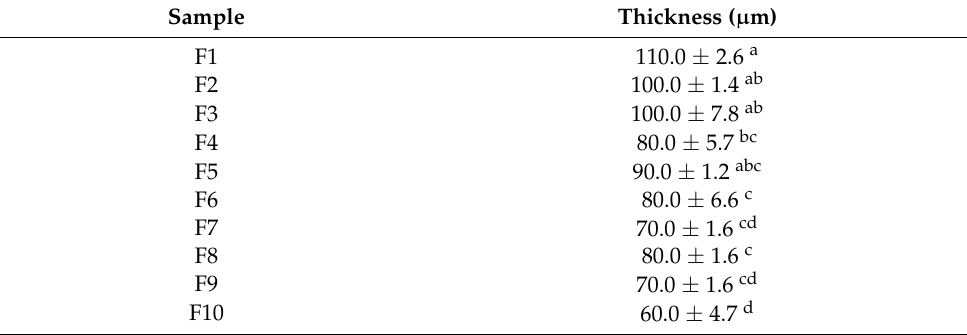
Table 3. Thickness and optical properties related to the biofilms